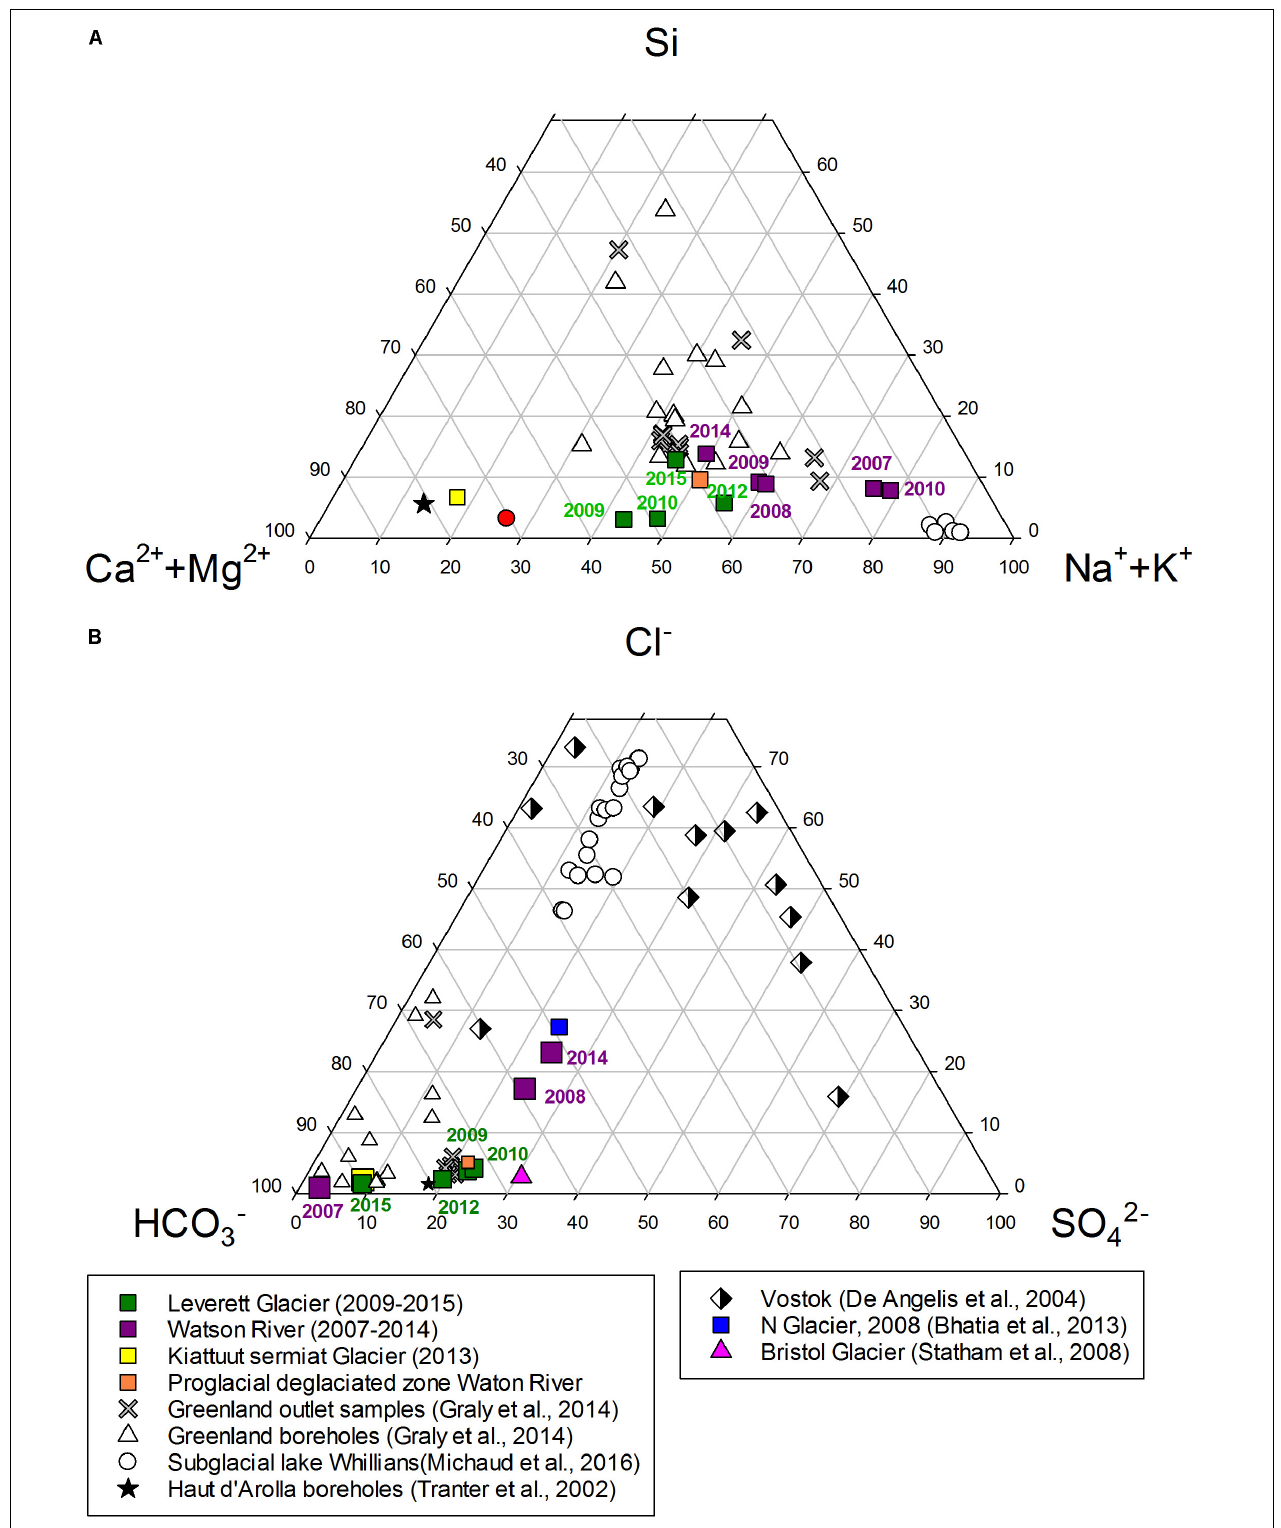
FIGURE 3 | (A) Relative molar abundances of cations and dissolved silica in GrIS catchments from this study, Subglacial lake Whillians, Greenlandic glaciated catchments (Boreholes and outlet samples from Issunguata Sermiat) and Haut d’ Arolla boreholes samples. (B) Relative molar abundances of anion in GrIS catchments from this study, boreholes and outlet samples from Issuanguata Sermiat, Subglacial lake Whillians and Subglacial lake Vostok.